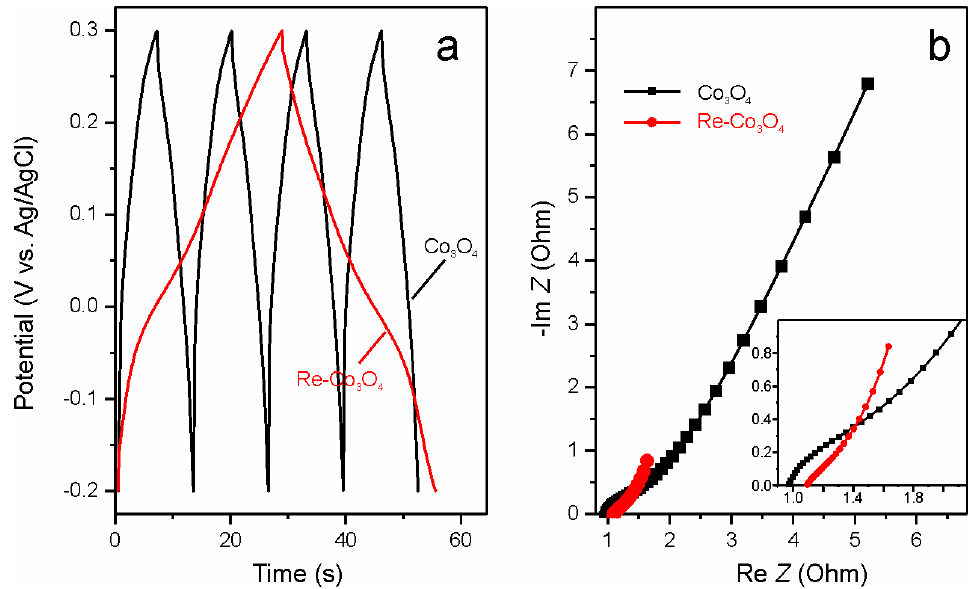
Figure 9. The GCD curves at a current density of 2 A g −1 ( a ) and Nyquist plots ( b ) of Co 3 O 4 electrode and the same electrode after reduction in H 2 (Re-Co 3 O 4 ), the inset indicates the Nyquist plots at high frequency region.